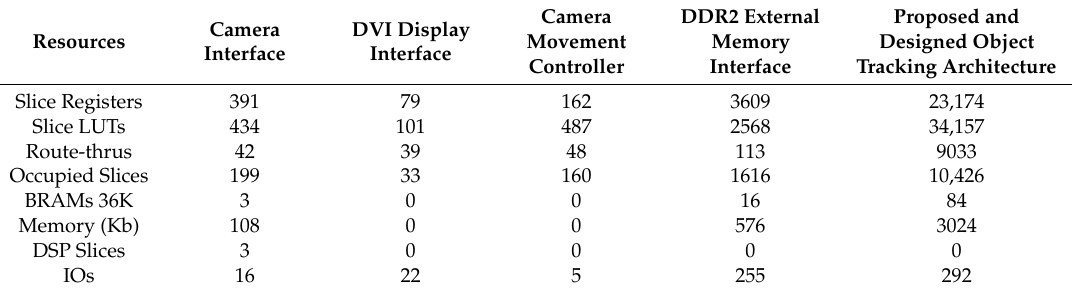
Table 1. FPGA resource utilization by object tracking architecture and four interfaces.